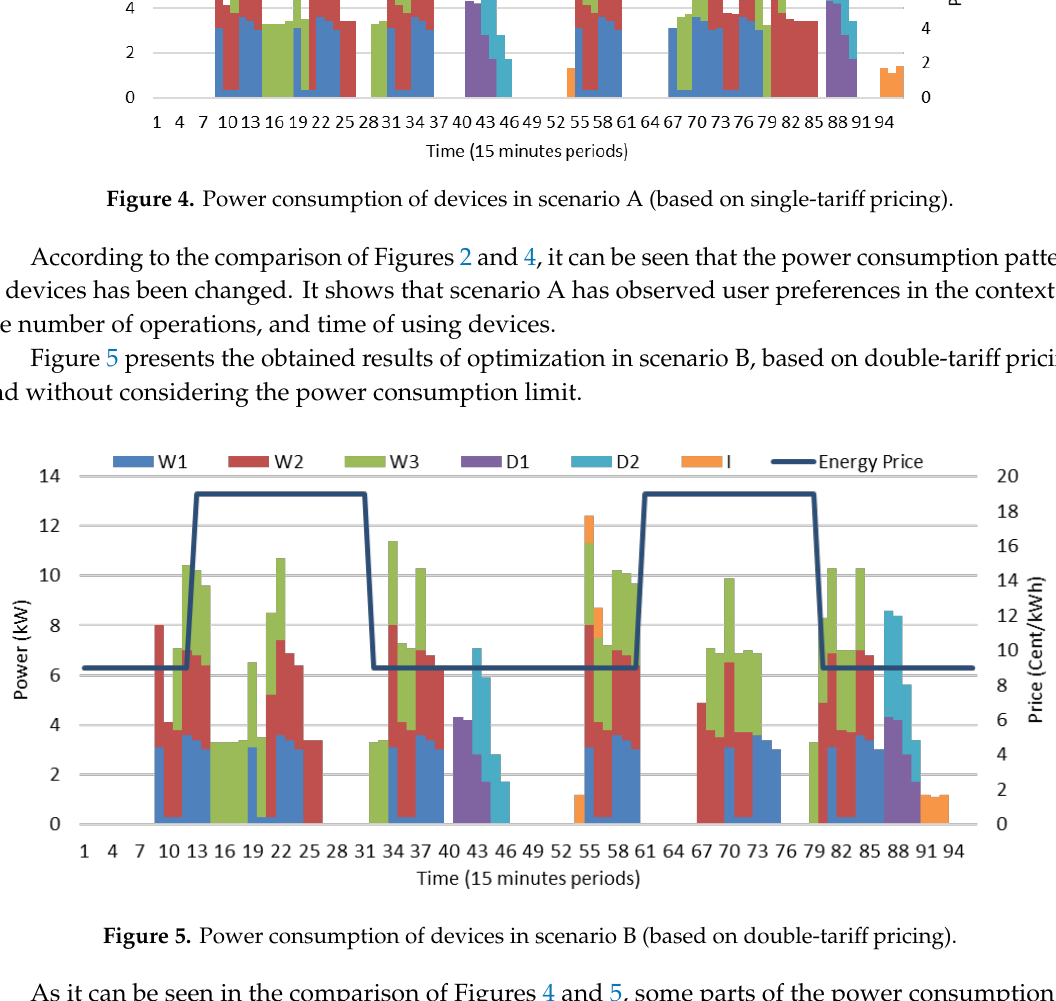
Figure 4. Power consumption of devices in scenario A (based on single-tariff pricing).